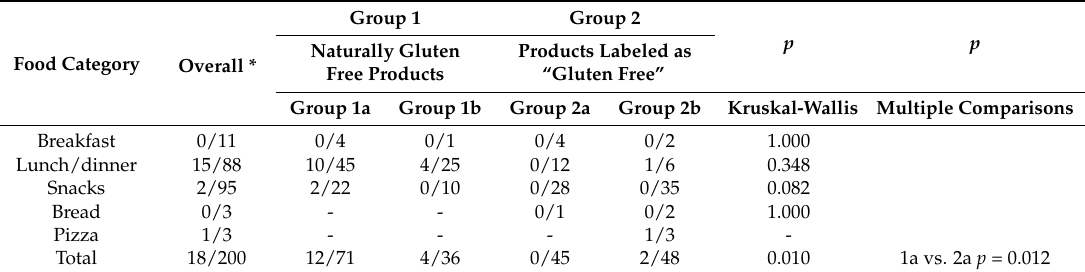
Table 3. Proportion of items containing >20 ppm of gluten by food category (contaminated/tested products).